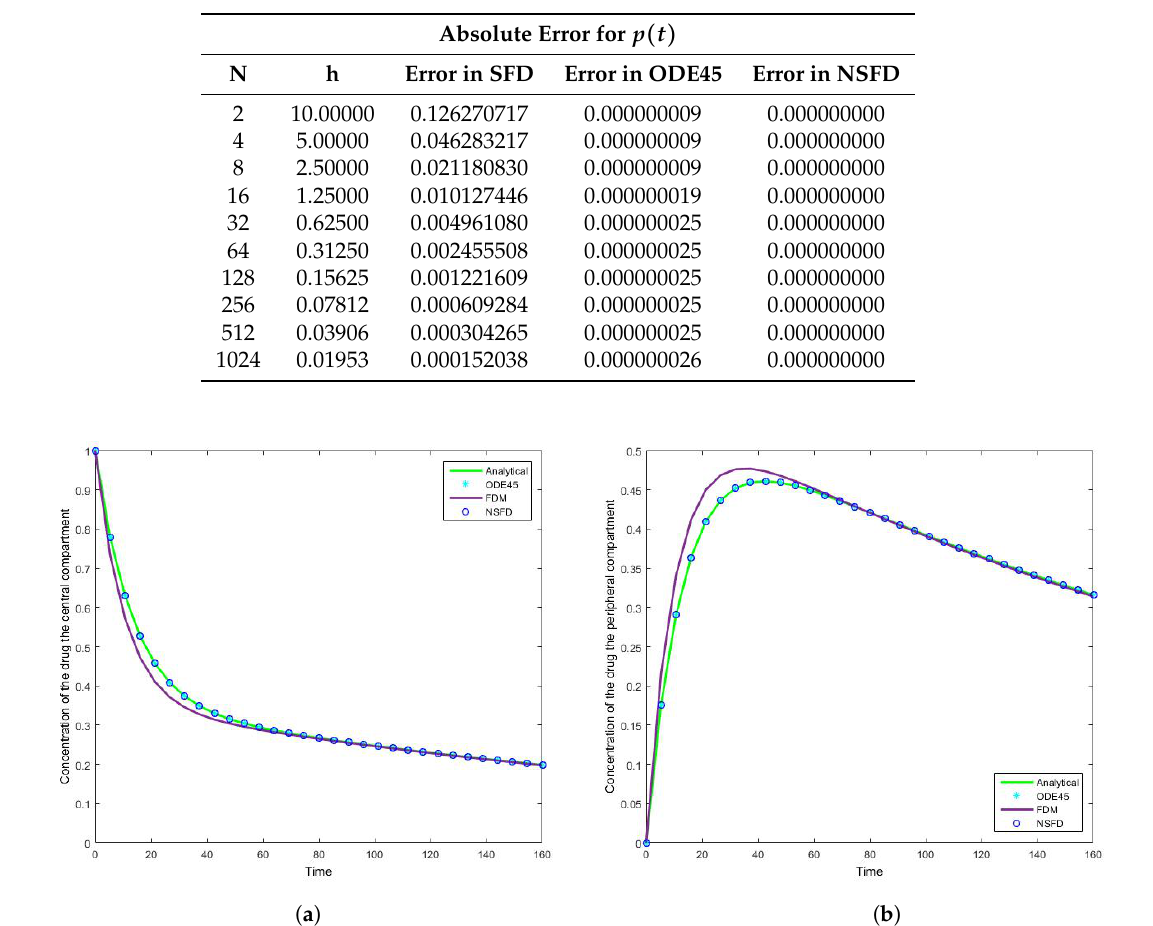
Figure 6. The concentration of the drug for Case 1 where h = 5.3333 in the ( a ) central compartment, and ( b ) peripheral compartment for a large time